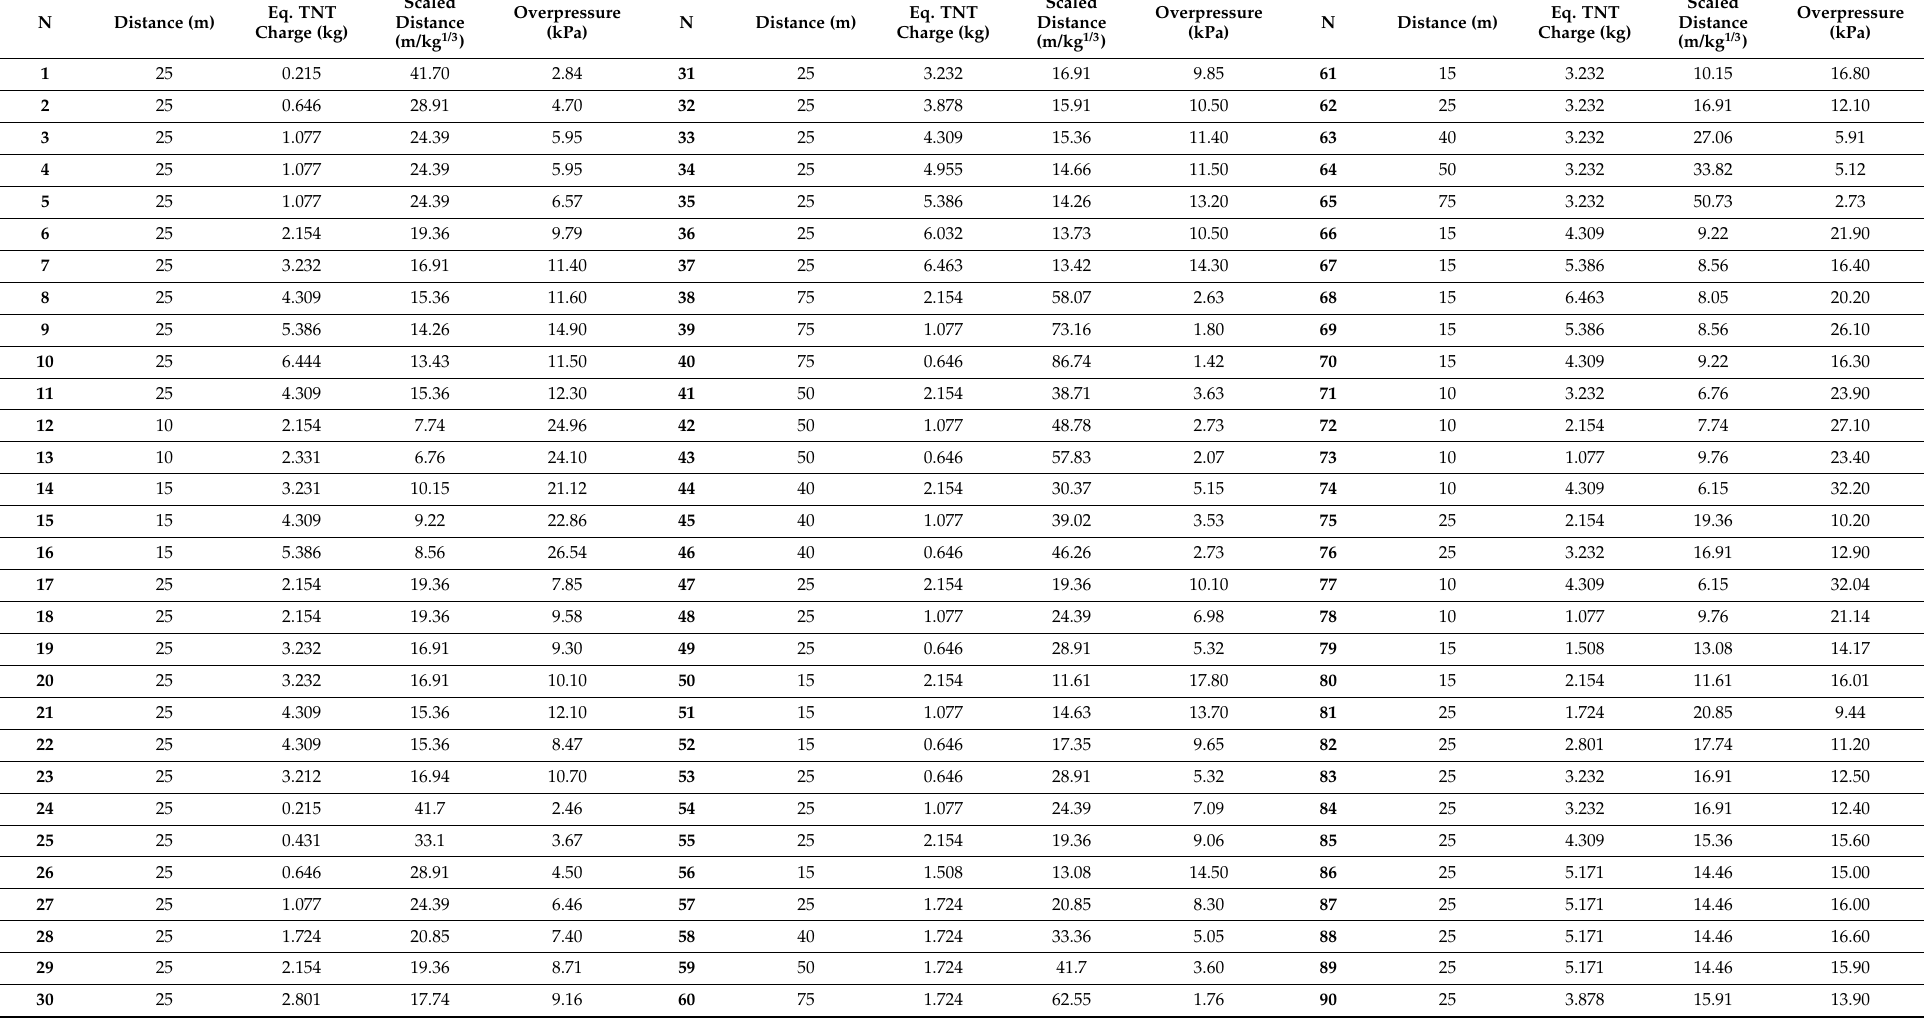
Table 7. TNT-equivalent charge and scaled distance for each Riodin-detonated